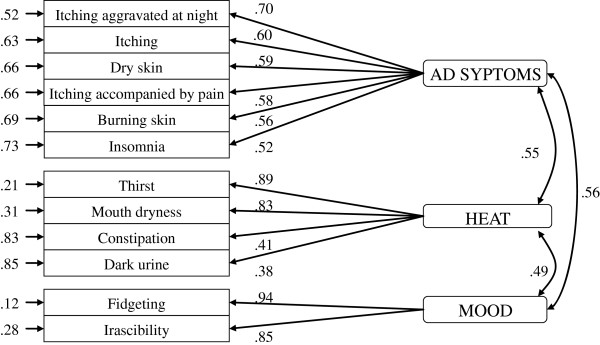
Parameter estimate values of the model.